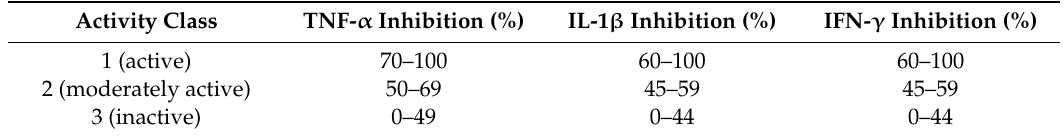
Table 1. Classification of the pharmacological activities.